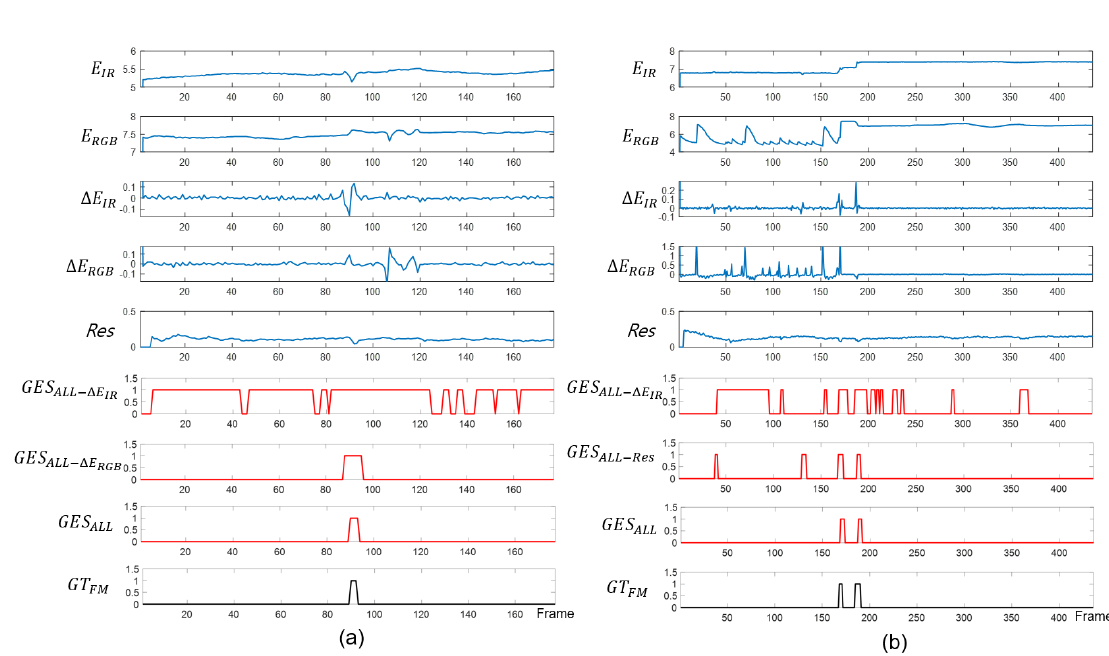
Figure 4. The ablation study of the proposed gradient of entropy method. ( a ) The bikeman sequence and ( b ) cycle3